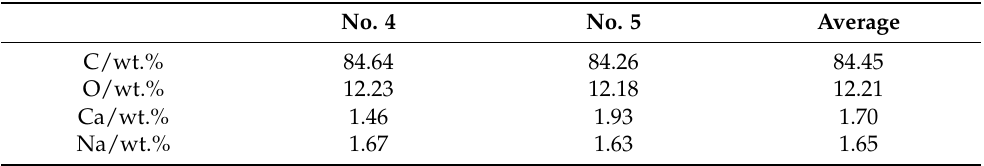
Table 2. Percentage of elements in pine tree biochar produced by flame-curtain pyrolysis estimated from XPS measurement.